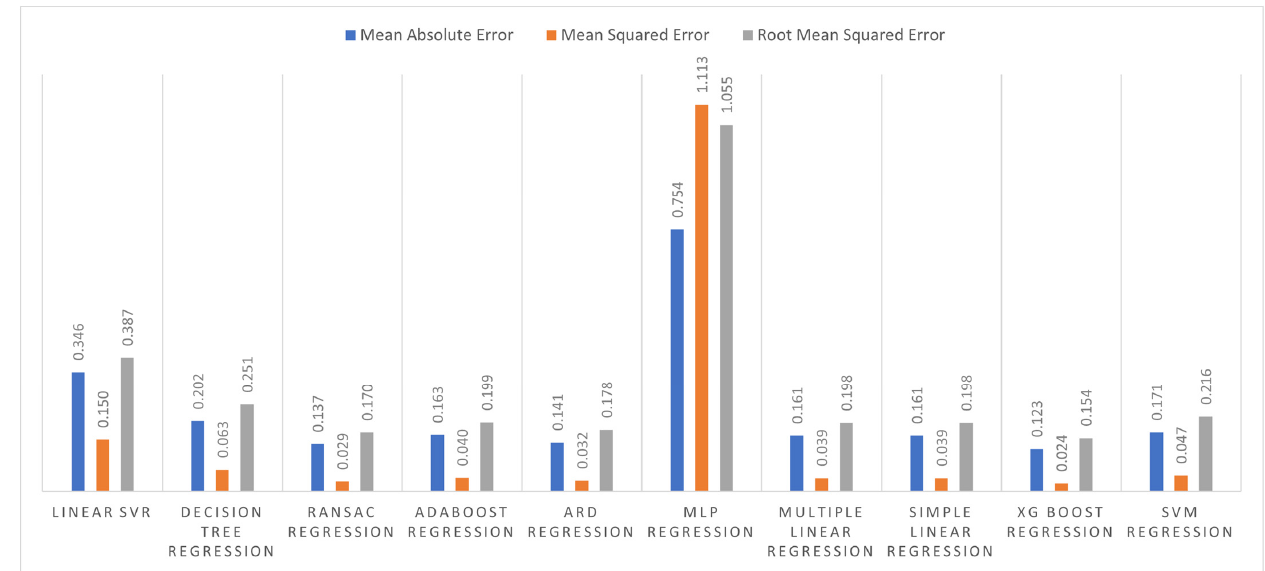
Figure 6. Errors in training and testing of regression algorithms.